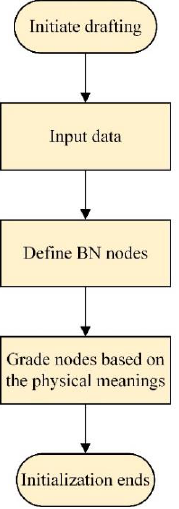
Figure 3. The initialization of drafting.